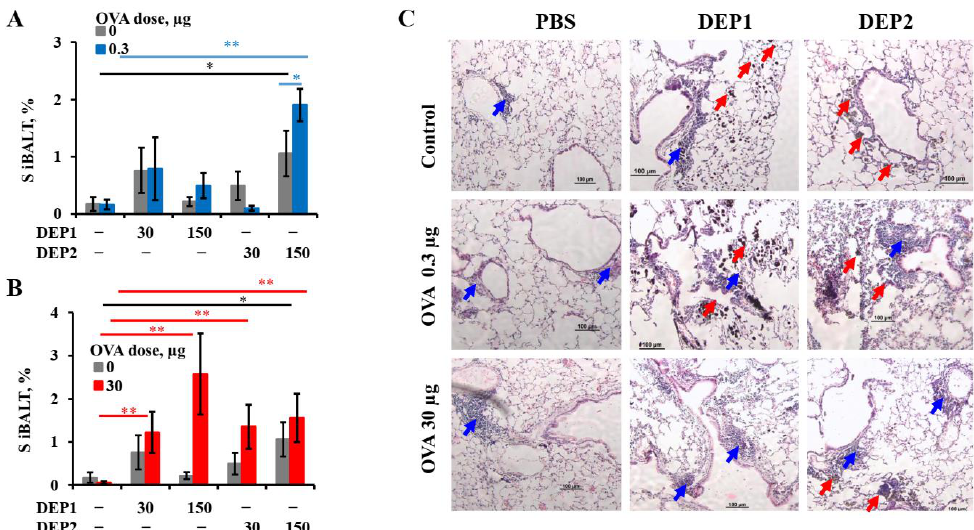
Figure 5. Histological analysis of lung tissue after prolonged OVA and DEP administration. BALB/c mice were immunized 2 – 3 times a week for eight weeks (a total of 18 immunizations) via the i.n. route with the indicated doses of OVA and different doses of DEP1 or DEP2. Following immunization, the mice were sacrificed and the lungs were isolated and stained for histological analysis (H&E). Relative areas of iBALT on histological sections of mice immunized with PBS and low OVA doses with or without DEPs in either 30 or 150 µg dose ( A ) or with high OVA doses with or without the same doses of DEPs ( B ), and representative histological images (100×) (samples from mice immunized with or without DEPs in 150 µg dose) ( C ) are shown. Red arrows correspond to DEPs; blue arrows show iBALTs. Black bars show significant differences between the groups immunized with particles alone and PBS control (* — p < 0.05; ** — p < 0.01). Blue and red bars show differences between the mice immunized with low (blue) or high (red) OVA doses together with DEPs and mice immunized with OVA alone. The experiment was performed twice. The graphs show the data from three representative experiments (total number of mice included in analysis from all experiments n = 6 – 7 per group). The data indicate biological replicates obtained from individual mice.